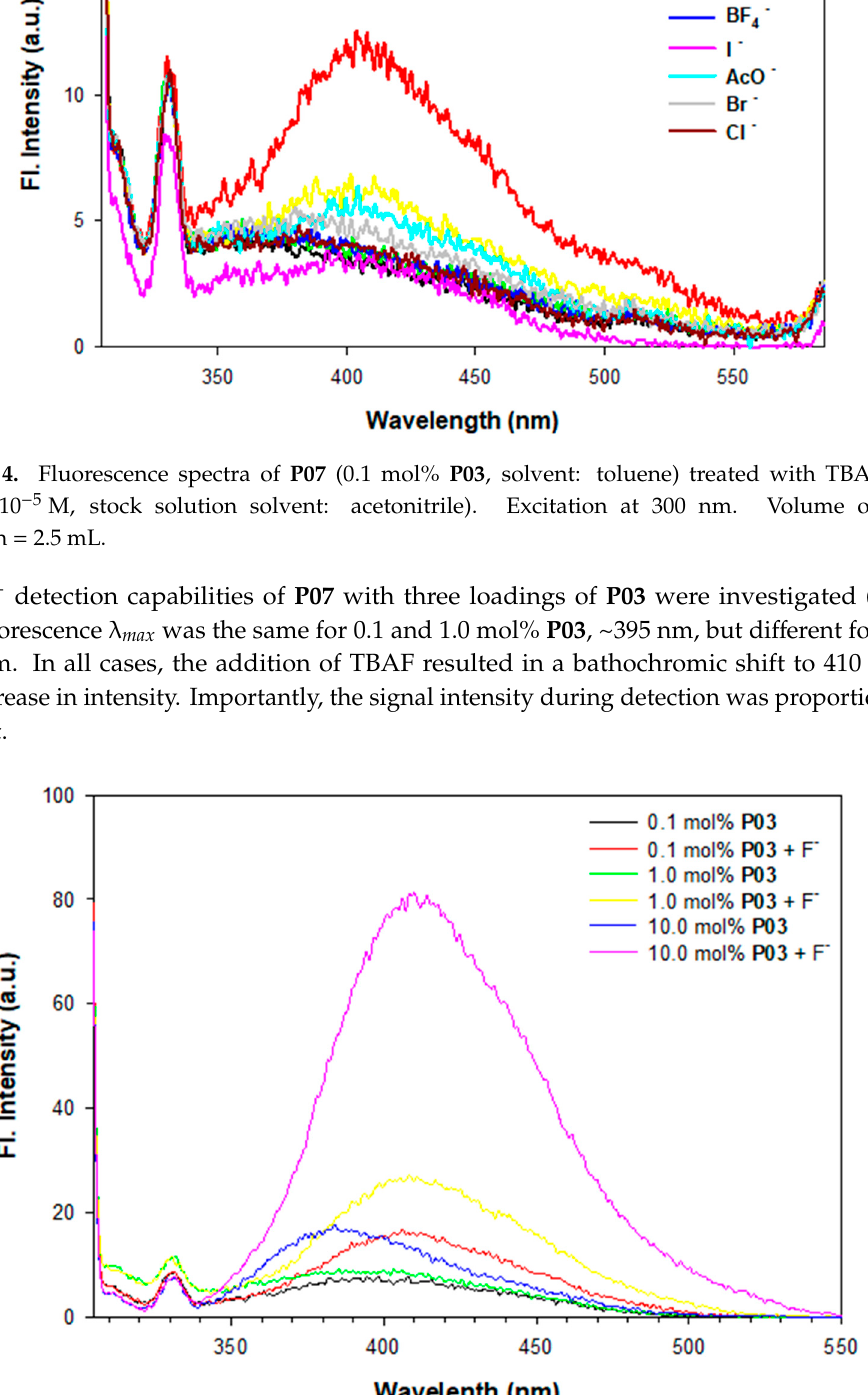
Figure 5. Fluorescence spectra of P07 (0.1, 1.0, and 10.0 mol% P03 , solvent: toluene) with TBAF (3.88 × 10 − 5 M, stock solution solvent: acetonitrile). Excitation at 300 nm. Volume of P07 solution = 2.5 mL. Fluorescence titration studies probed the behavior of P07 (0.1 mol% P03 ) with varying concentrations of